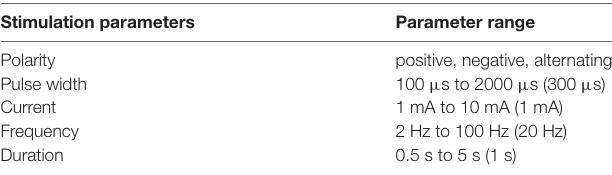
TABLE 2 | The range of pulse parameters used for mapping and testing.